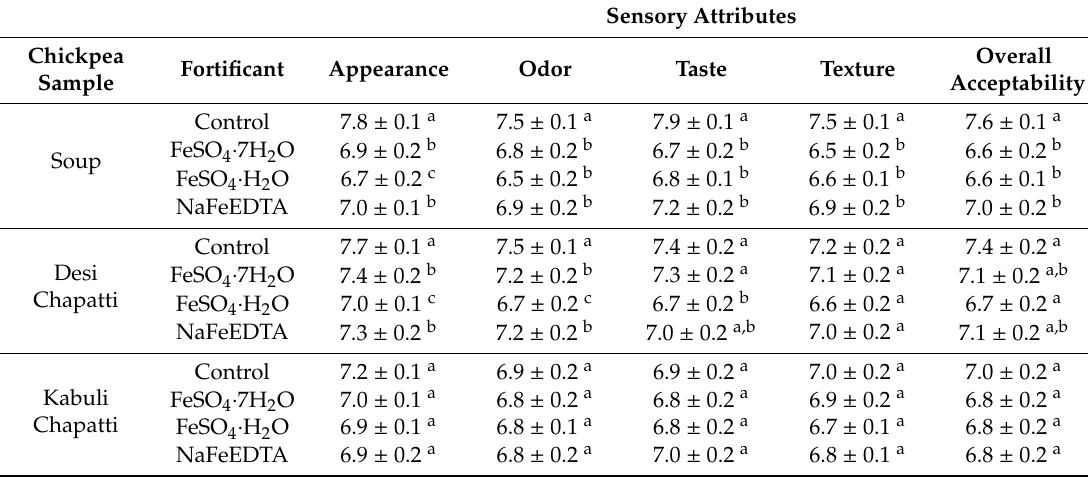
Table 4. Hedonic scale responses for three cooked chickpea samples (soup prepared with split desi seed, chapattis prepared from desi flour and chapattis prepared from kabuli flour) fortified with